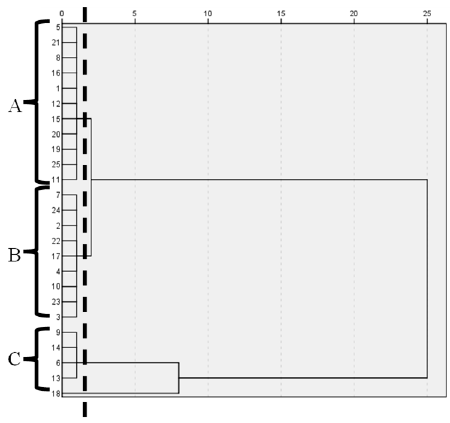
Figure 10. Grouping based on the characteristics of biological information.